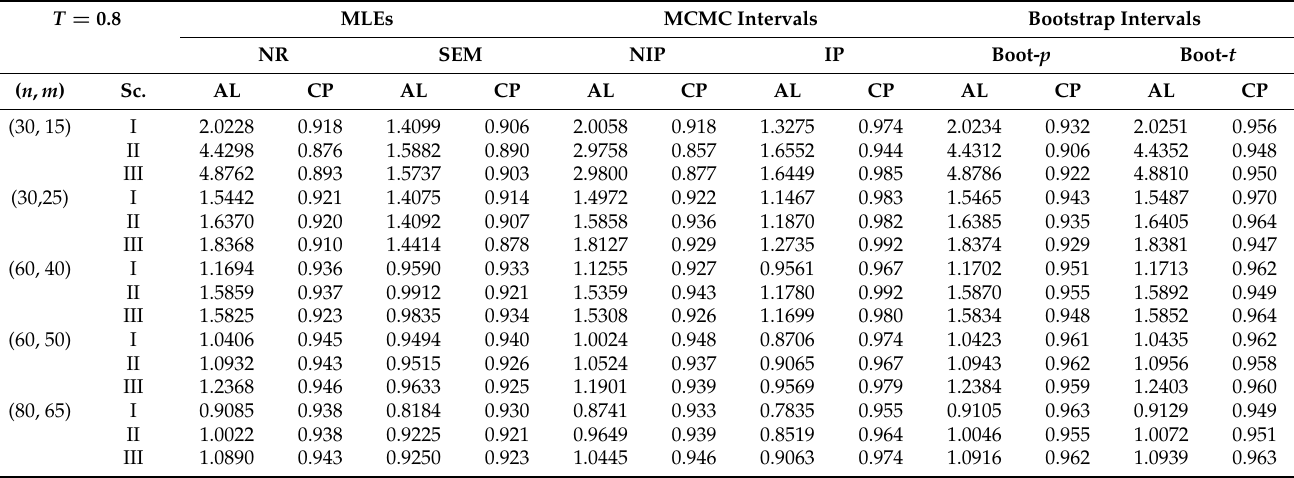
Table 14. 95% CI’s, average length (AL) and coverage percentage (CP) of approximate, Bayes and bootstrap confidence intervals of λ under informative prior (IP) and noninformative (NIP) prior, for different schemes with different values of n and m, when ( θ 1 , θ 2 , λ ) = (0.05, 0.06,